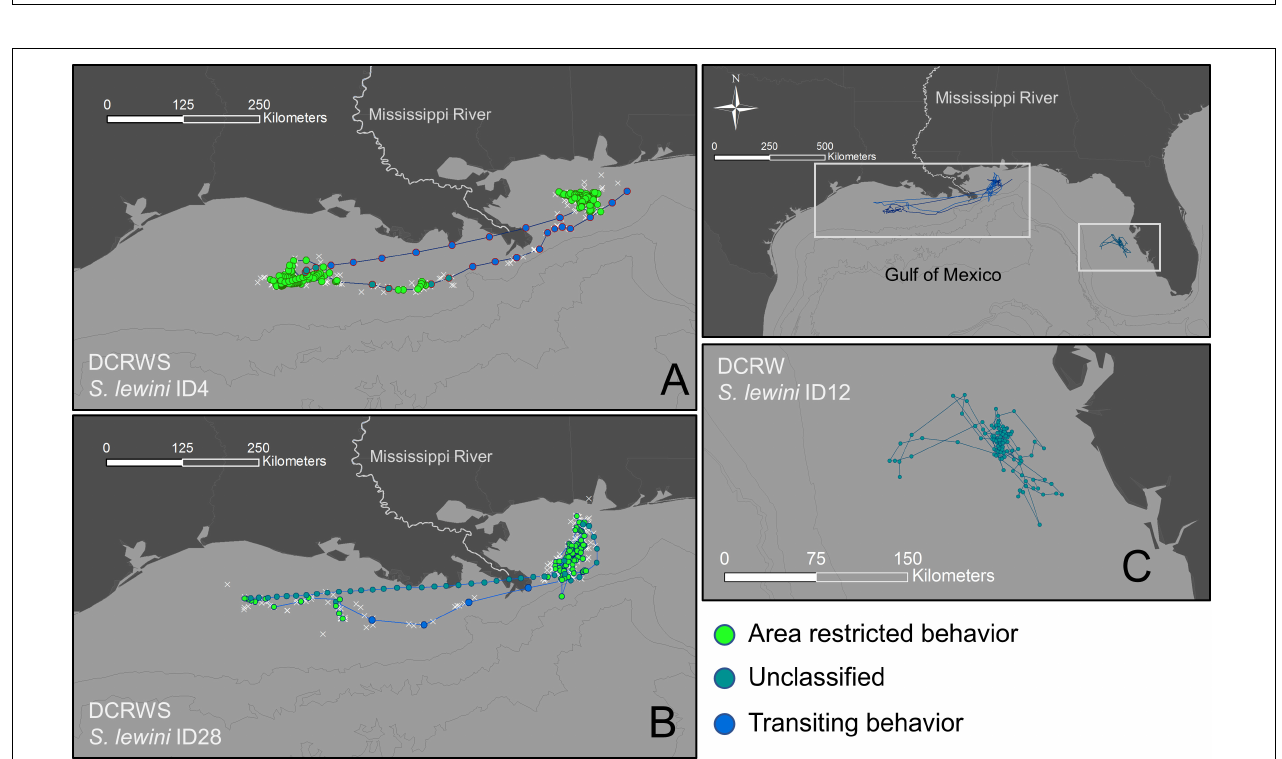
FIGURE 5 | Tracks for scalloped hammerheads ID4 (A) , ID28 (B) , and ID12 (C) showing observed (white crosses) locations and estimated (filled circles) locations from first-difference correlated random walk switching (A,B) and first-difference correlated random walk (C) models.